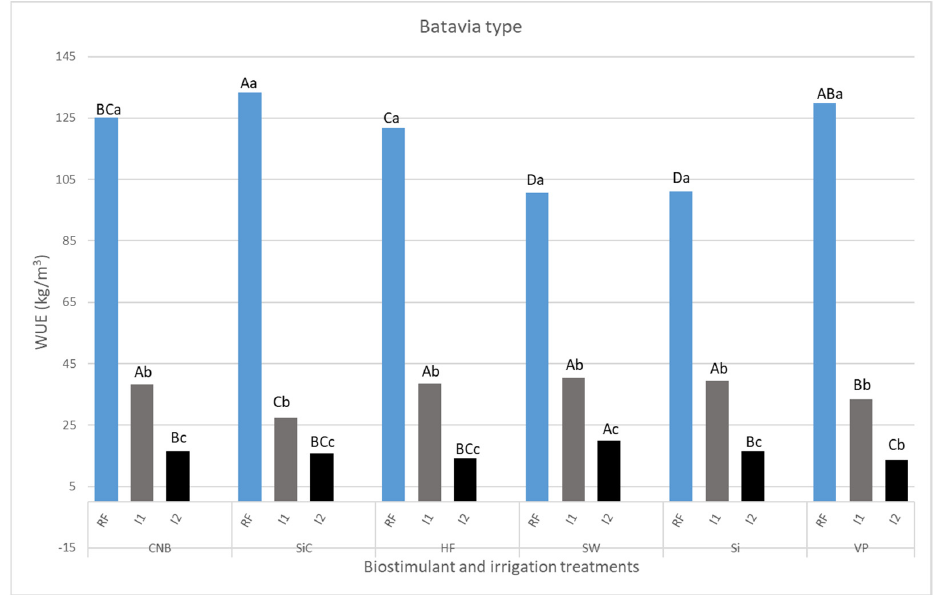
Figure 4. Water use efficiency (WUE) of Batavia-type lettuce plants in relation to biostimulants and irrigation regime. Capital letters above bars indicate significant differences between the means of the same irrigation regime, according to Tukey’s HSD test at p = 0.05. Lowercase letters above bars indicate significant differences between the means of the same biostimulant treatment, according to Tukey’s HSD test at p = 0.05. SW: algae extracts + macronutrients + amino acids; HF: humic + fulvic acids; SiC: Si + Ca; Si: Si; VP: plant proteins + amino acids; C NB : without addition of biostimulants; RF: rain-fed plants; IR.1: 50% of field capacity; IR.2: 100% of field capacity.